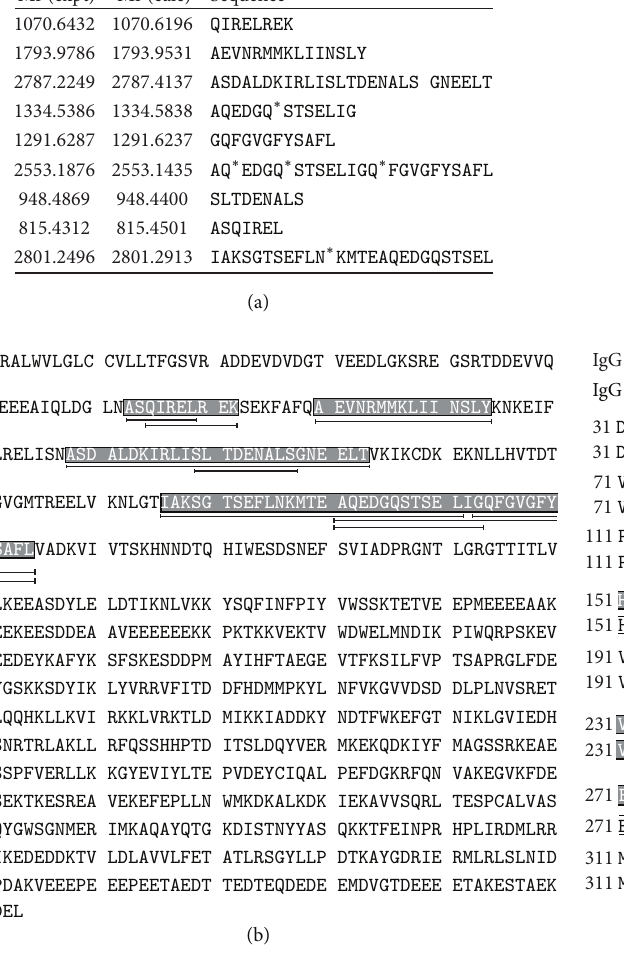
Figure 3: Identification of sites of binding in both Grp94 and IgG. (a) Nine unique peptides mapping the N-terminal region of human Grp94 were obtained after digestion of spots at about 50 kDa in bands positive for both Grp94 and IgG (evidenced in Figure 2) and submitted to ESI-mass analysis. Only one peptide was produced by trypsin digestion, whereas others might be due to autoproteolytic cleavage. Calculated molecular mass of each peptide is reported near the corresponding sequence. ∗ Aminoacid residue deamidated. (b) Sequence of human Grp94 (Hsp90 B1, Swiss Prot entry P14625). Sequences corresponding to the observed peptides are grey boxed. More than one peptide is found to match the boxed sequences (indicated by double arrow lines below the sequence). (c) Western blotting for both Grp94 and IgG of human IgG and recombinant rabbit Grp94 incubated both alone (control) and together at the final molar concentration of 2 :1 to form Grp94-IgG complexes, as specified in Section 2. Five 𝜇 g IgG and 1.3 𝜇 g Grp94 were loaded onto 10% polyacrylamide gel after reducing treatment of samples. After blotting, the membrane was first exposed to monoclonal anti-Grp94 Abs and then, after stripping, to anti-human IgG Abs. The immune reaction was detected as specified in the legend to Figure 2. The arrow on the left indicates the 50 kDa band excised from the gel of SDS-PAGE for mass analysis and found positive for Grp94. No immune reaction at 50 kDa was found in control Grp94. (d) Human IGHG1 amino acid sequence containing CH1 (residues 1–98), hinge (residues 99–110), CH2 (residues 111–223), and CH3 regions (residues 254–275) in both control IgG and IgG + Grp94. Coverage of the Ig 𝛾 -1 chain C for both sample was highly reproducible. Peptides identified in both samples are boxed in grey, whereas the missing sequences in IgG + Grp94 are in clear boxes. Empty arrows indicate the cleavage points by trypsin. Arrows on right indicate that the coverage sequence extends to the following